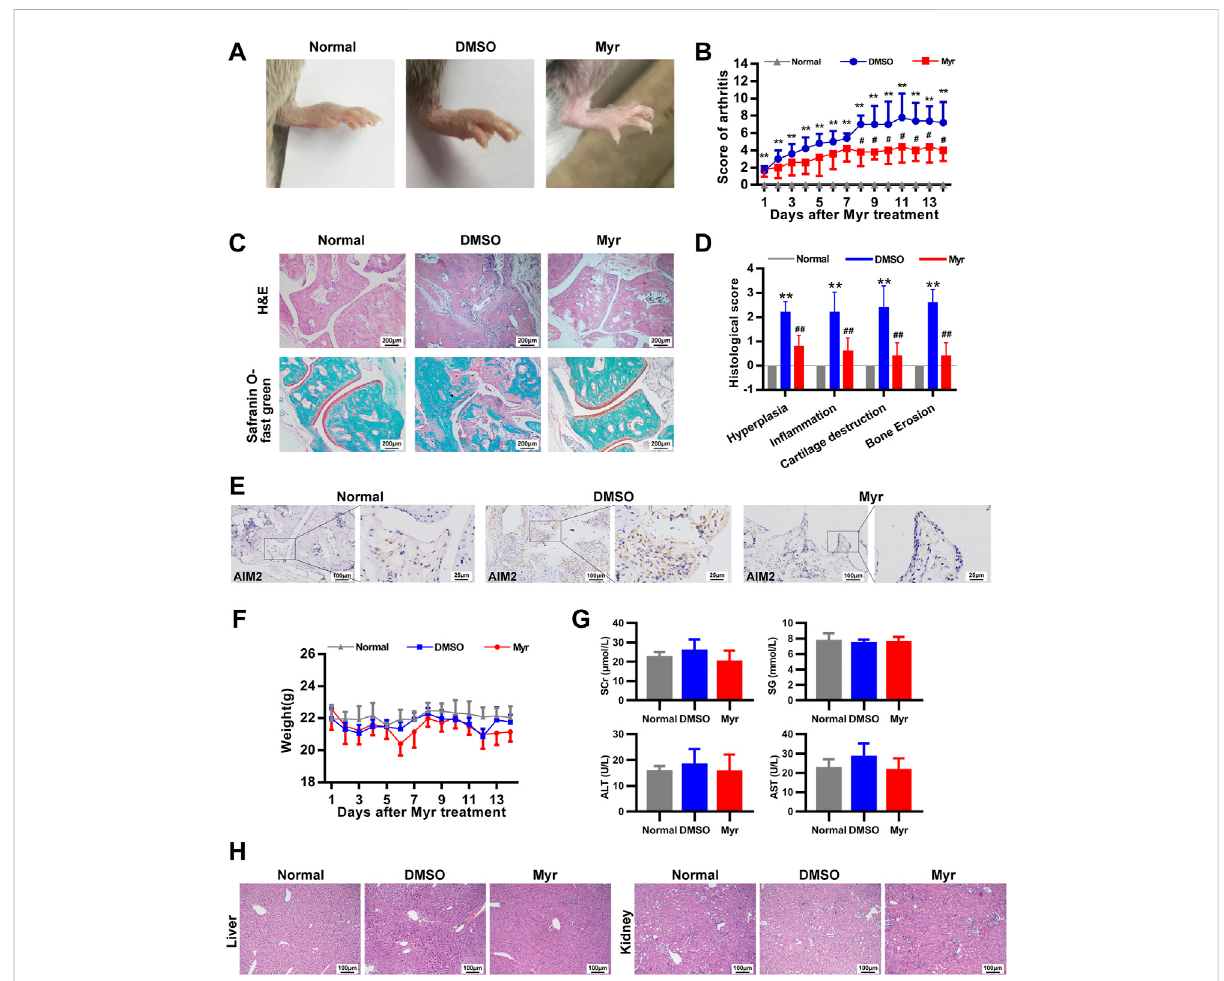
FIGURE 6 Myr reducestheseverityofarthritisinmicewithCIA.CIAmiceweregavagedwithMyr (100 mg/kg/d, n =5)or1%DMSO(asamodelcontrol,n=5) daily for 14 days, normal mice were presented as normal control (normal). (A,B) Myr attenuated clinical symptom in CIA mice. The values in (B) are the mean ± SD of clinical scores in normal mice or mice treated with Myr or DMSO. (C,D) H&E and Safranin O-Fast green staining was used to evaluate synovial hyperplasia, in fl ammation, cartilage destruction, and bone erosion. Original magni fi cation, ×100. The graph (D) indicates the mean ± SD scores for synovial hyperplasia, in fl ammation, cartilage destruction, and bone erosion. (E) Immunohistochemical staining was used to measure the expression of AIM2 in synovial tissues from mice. Representative images were from normal mice, DMSO-treated mice, and Myr-treated mice (original magni fi cation,×200). (F) EffectofMyronBodyweightinmice.Datawereshownasthemean±SD. (G) EffectofMyronthelevelsofserumglucose(SG), serum creatinine (SCr), and alanine aminotransferase (ALT) and aspartate aminotransferase (AST) in mice. Data were shown as the mean ± SD. (H) Representative images show the pathological changes of the liver and kidney in mice. Graph indicates the mean ± SD from 5 mice. Original magni fi cation, ×200. * p < 0.05, ** p < 0.01 versus Normal, # p < 0.05, ## p < 0.01 versus